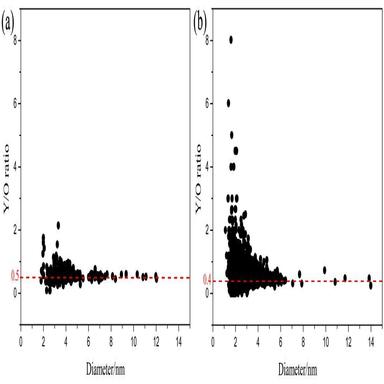
Y/O ratio of nanoclusters in (a) ODS Eurofer and (b) ODS Eurofer–2V–1.2Ta.